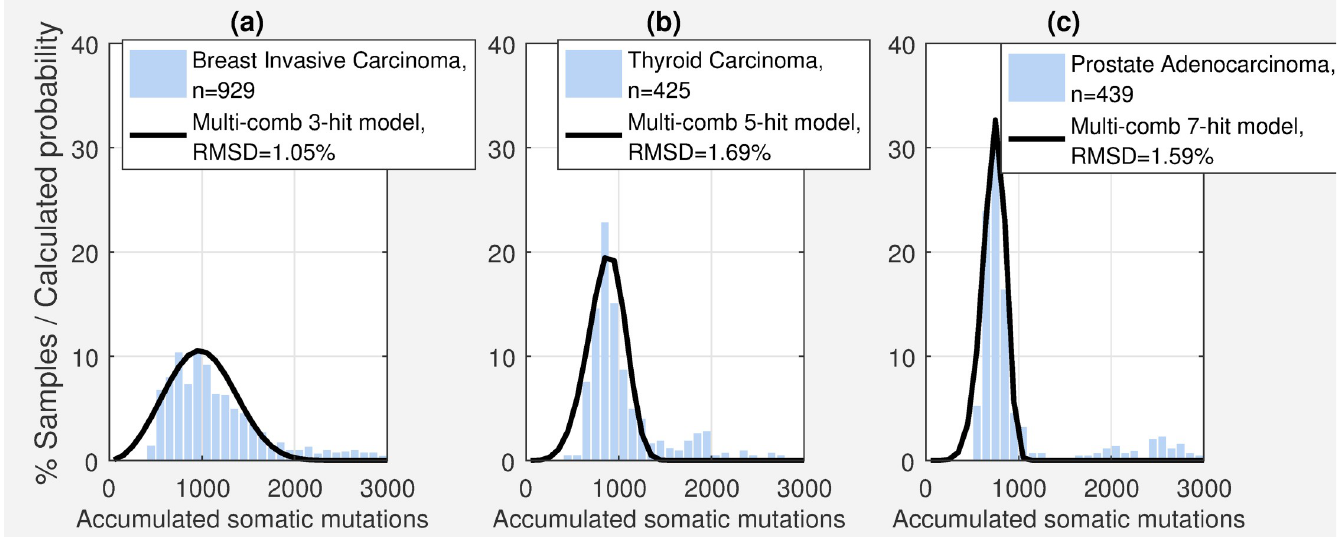
Fig 3. Number of hits estimated by the multi-combination multi-hit model depends on the distribution of somatic mutations. (a)-(c) Examples of three cancer types exhibiting distinct distributions and the predicted probability distribution for the optimal model, showing a corresponding difference in the number of hits. S1–S3 Figs show the distributions for the 17 cancer types with at least 200